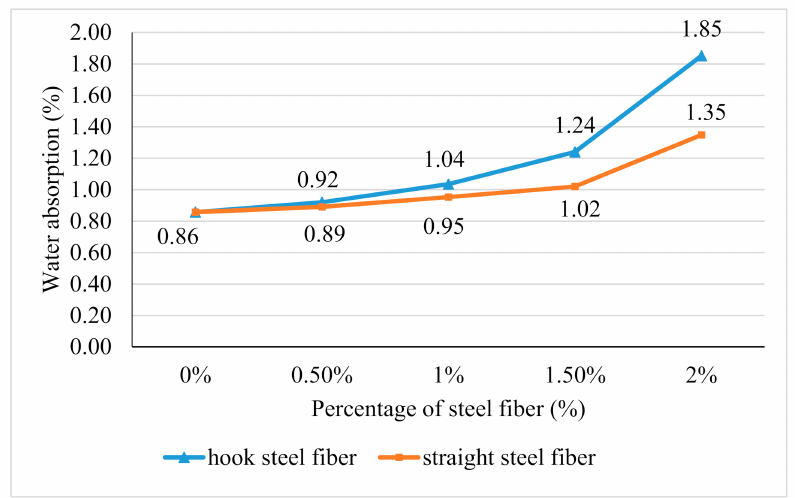
Figure 5. Water absorption of geopolymer concrete with the addition of hooked and straight steel